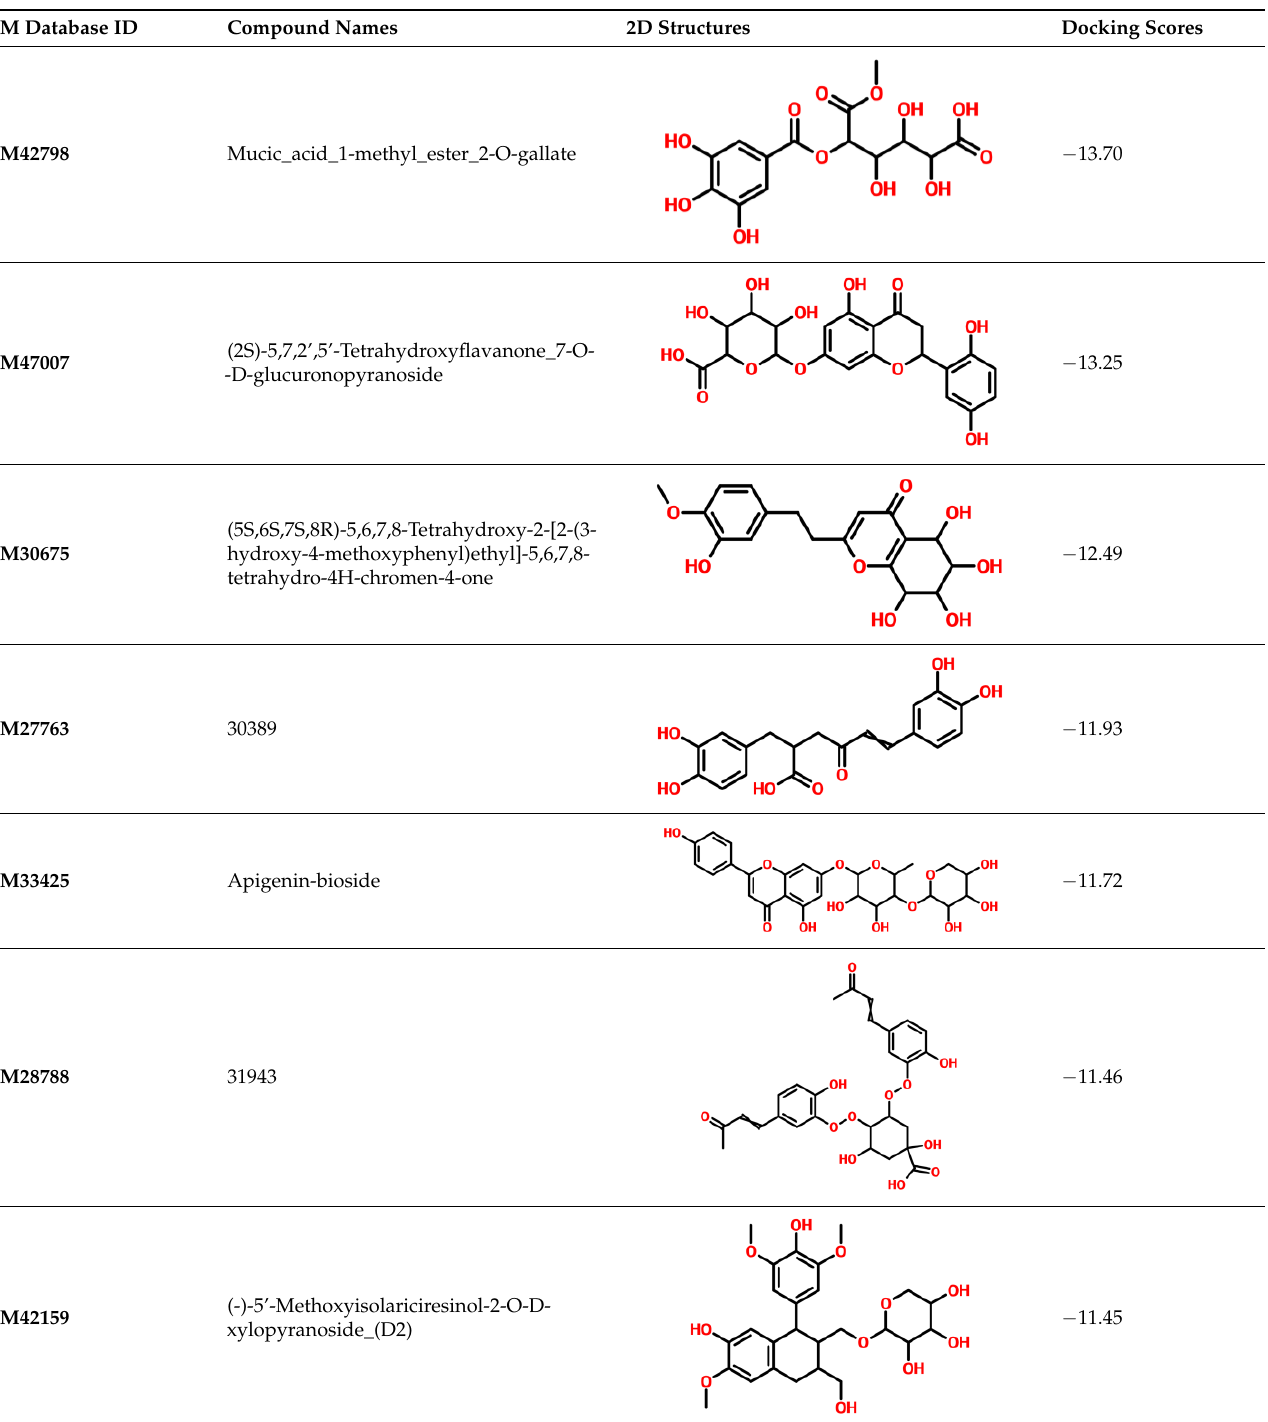
Table 1. List of top 11 scoring compounds with their TCM IDs, compounds names, 3D structures, and docking scores.